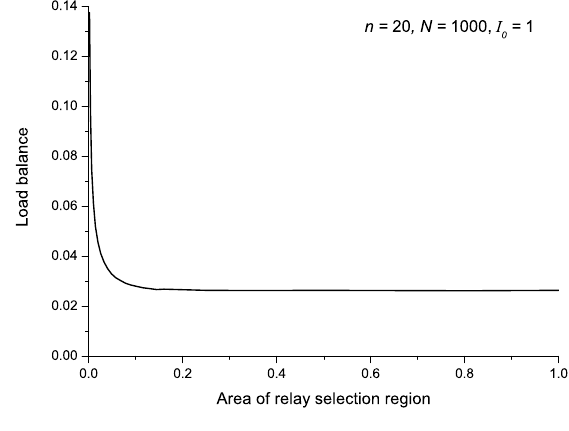
Figure 7. Load balance performance of protocol 3 vs. Area of relay selection region when n = 20 , N = 1000 and I